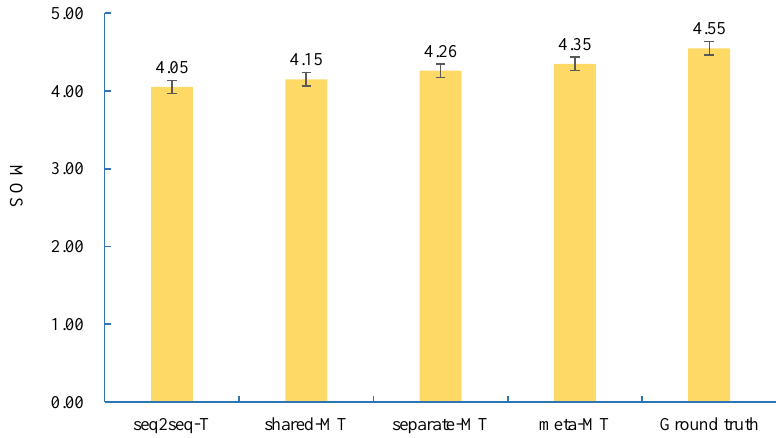
Figure 6. The average MOS scores of synthesized Tibetan speech samples under 95% confidence intervals.